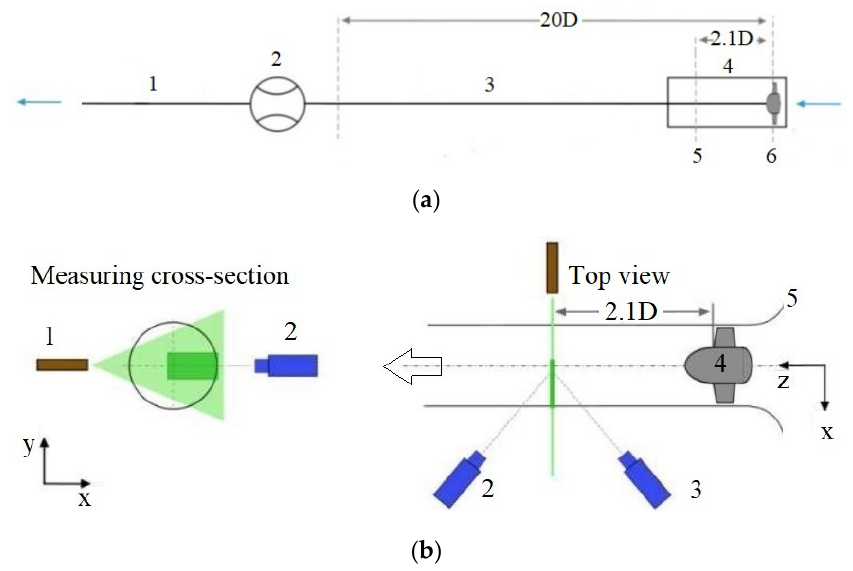
Figure 1. Test rig: ( a ) 1—flexible hose, 2—Venturi flow meter, 3—straight aluminum duct, 4—transparent pipe section, 5—measuring cross-section, and 6—axial fan impeller. ( b ) 1—Nd:YLF laser; 2 and 3—left and right PIV fast cameras, respectively; 4—axial fan impeller; and 5—profiled free bell-mouth intake.